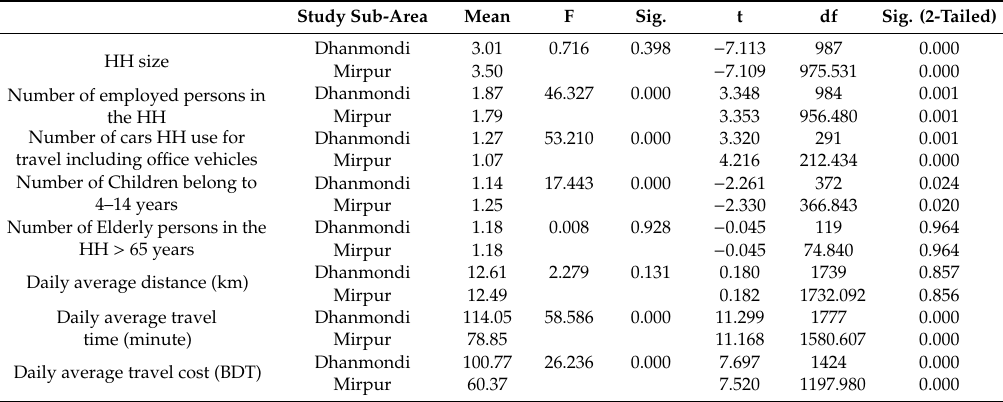
Table 1. Area-wise independent sample T test results for some variables. Df: degree of freedom. HH: Household.